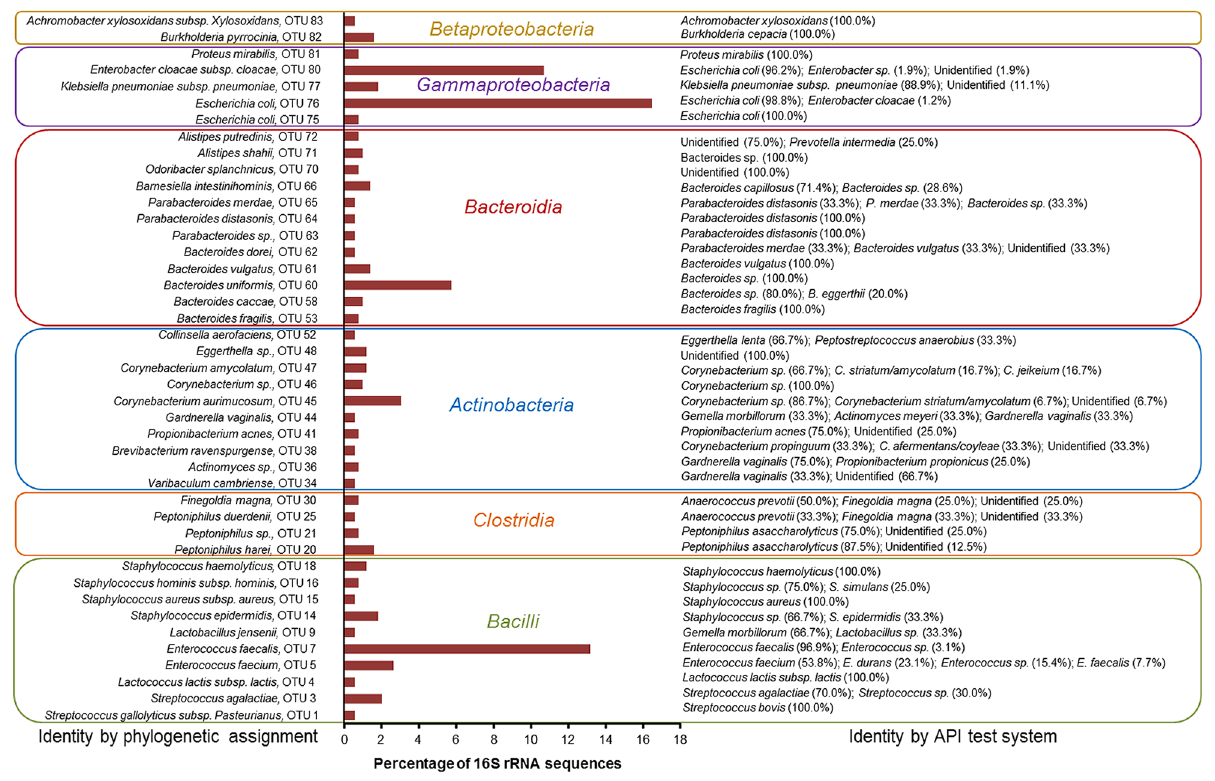
Fig 1. Relative proportions of the different OTUs obtained in CBUs positive for microbial contamination. OTUs were identified by phylogenetic inference of 16S rRNA sequences and by API test system. In some cases, isolates grouped into an OTU showed different results using the API test system, whose relative proportions are shown in brackets. Only OTUs clustering more than 2 isolates are